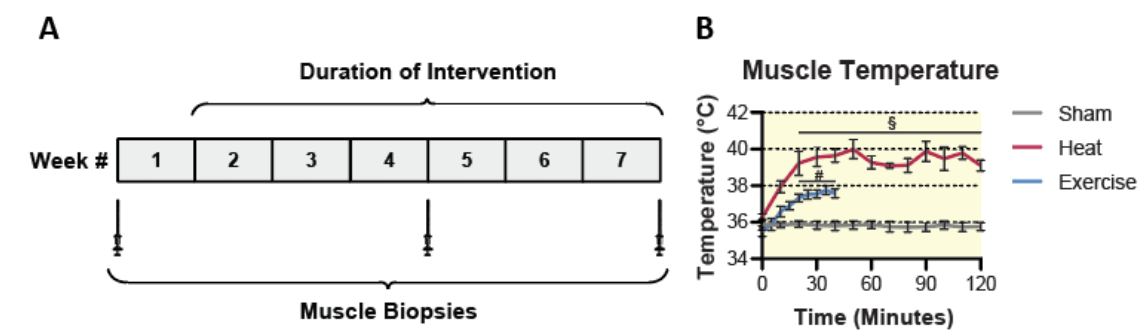
Figure 1. Study timeline ( A ), and internal muscle temperature during sham, HT and EX interventions ( B ). Statistical difference in the HT group compared to time 0 is indicated by § ( p < 0.001). Statistical difference in the EX group compared to time 0 is indicated by # ( p < 0.001). Results are represented as mean ± SEM ( n = 7–8).